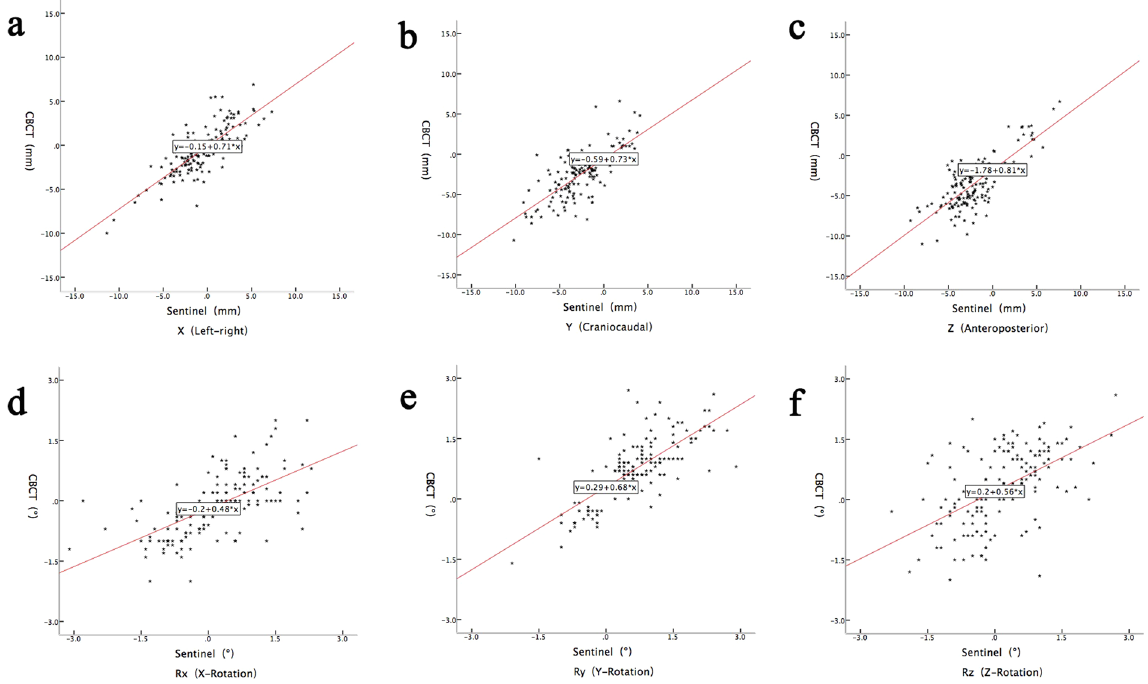
Figure 1. The scatter spot of CBCT and Sentinel error before moving couch. The correlation of CE and SE- before in the three translation directions ( a – c ). The correlation of CE and SE-before in the three rotations about the X, Y, Z axes ( d – f ).